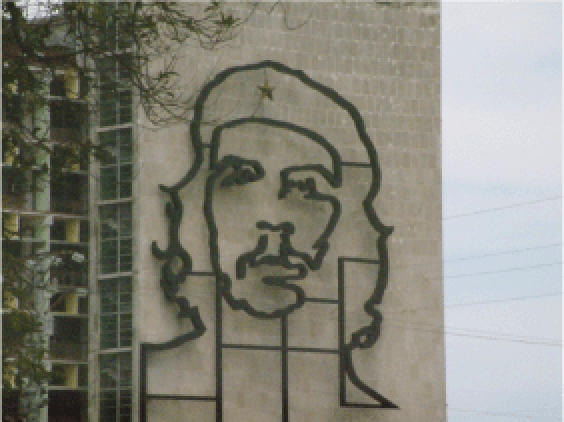
Che Guevara's “revolutionary medicine” stressed the social origins of illness and the need for social change to improve health conditions(Photo: Marko Faas)